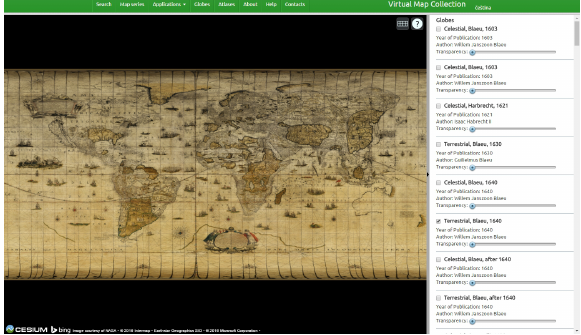
Figure 7. Digital globe in the form of georeferenced